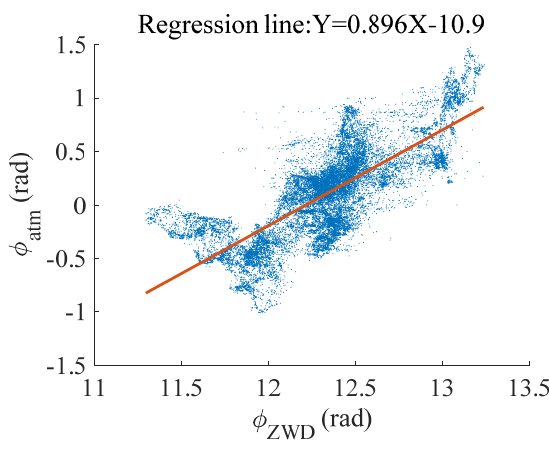
Figure 5. Example of scattergram between ZWD phase and atmospheric phase delay by using images 0 and 1 listed in